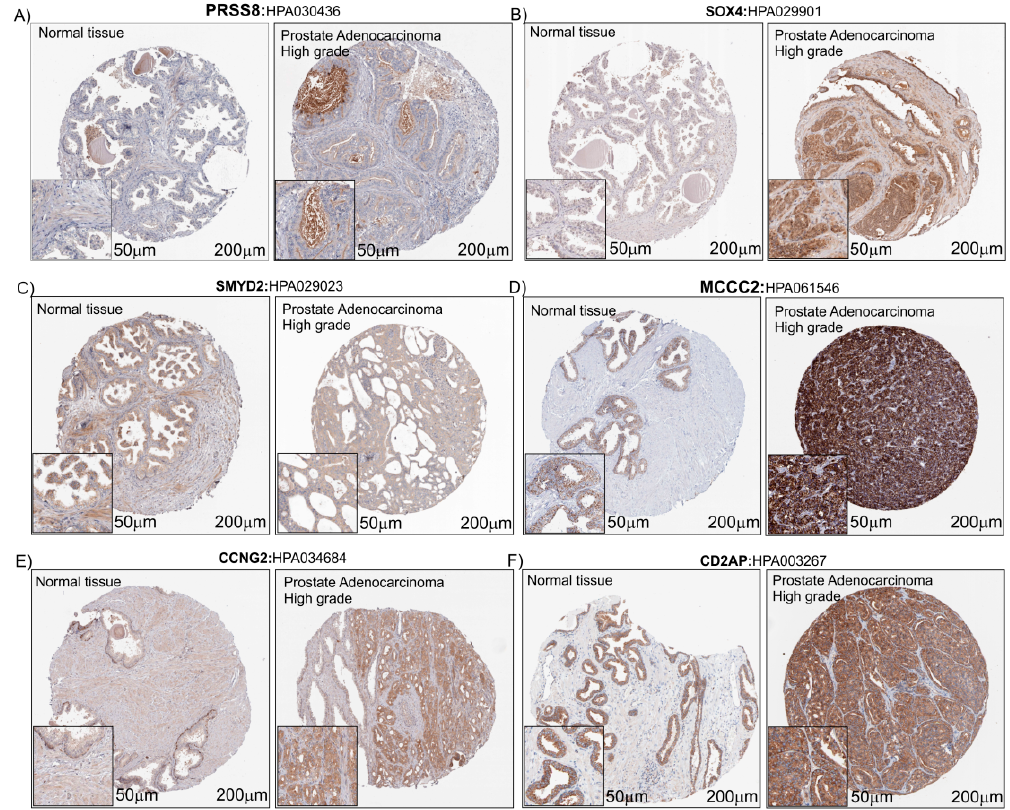
Figure 7. IHC of the six PCa-selected genes. Immunostaining for PRSS8 ( A ), SOX4 ( B ), SMYD2 ( C ), MCCC2 ( D ), CCNG2 ( E ) and CD2AP ( F ) in Prostate Adenocarcinoma High grade compared to normal prostate tissue (Control) (see the text for the details). The images downloaded from the Human Atlas Project (https: // www.proteinatlas.org / ) have been re-adapted using CorelDraw. The original files web site links are available as well as the complete analyzes, in Table 1 and Table